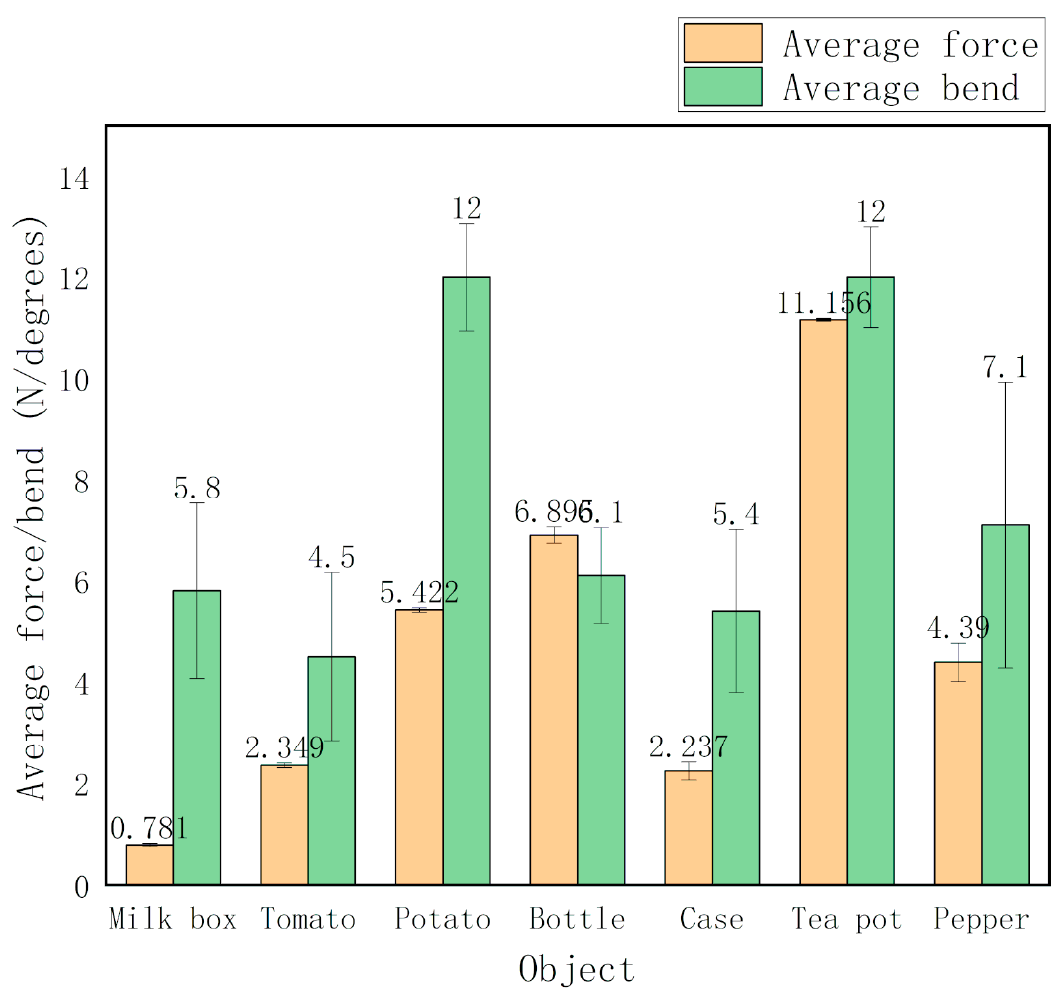
Figure 12. The measurement error of force and bending angle under different conditions. Table 2. Comparison of grasping bending results (degrees).